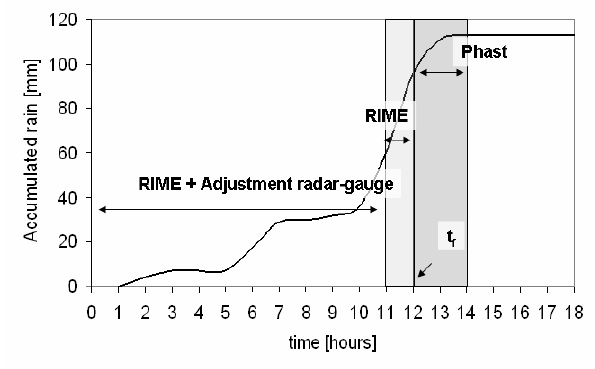
Fig. 2. Reference schematization for the building of a rainfall sce- nario. The first part is generated using the algorithm RIME and the radar-gauge adjustment; the hour before the forecast time ( t f ) is generated using only radar observations (RIME) and the nowcasted part using the algorithm